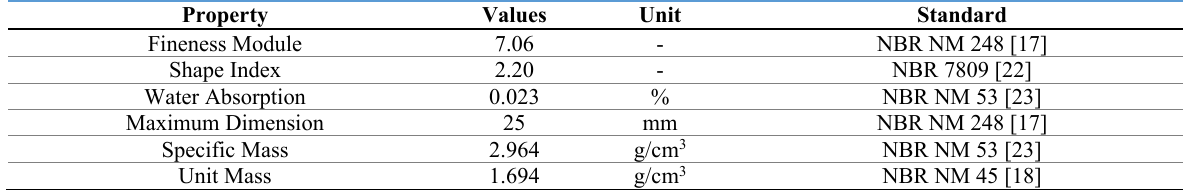
Table 3. Physical properties of the fine